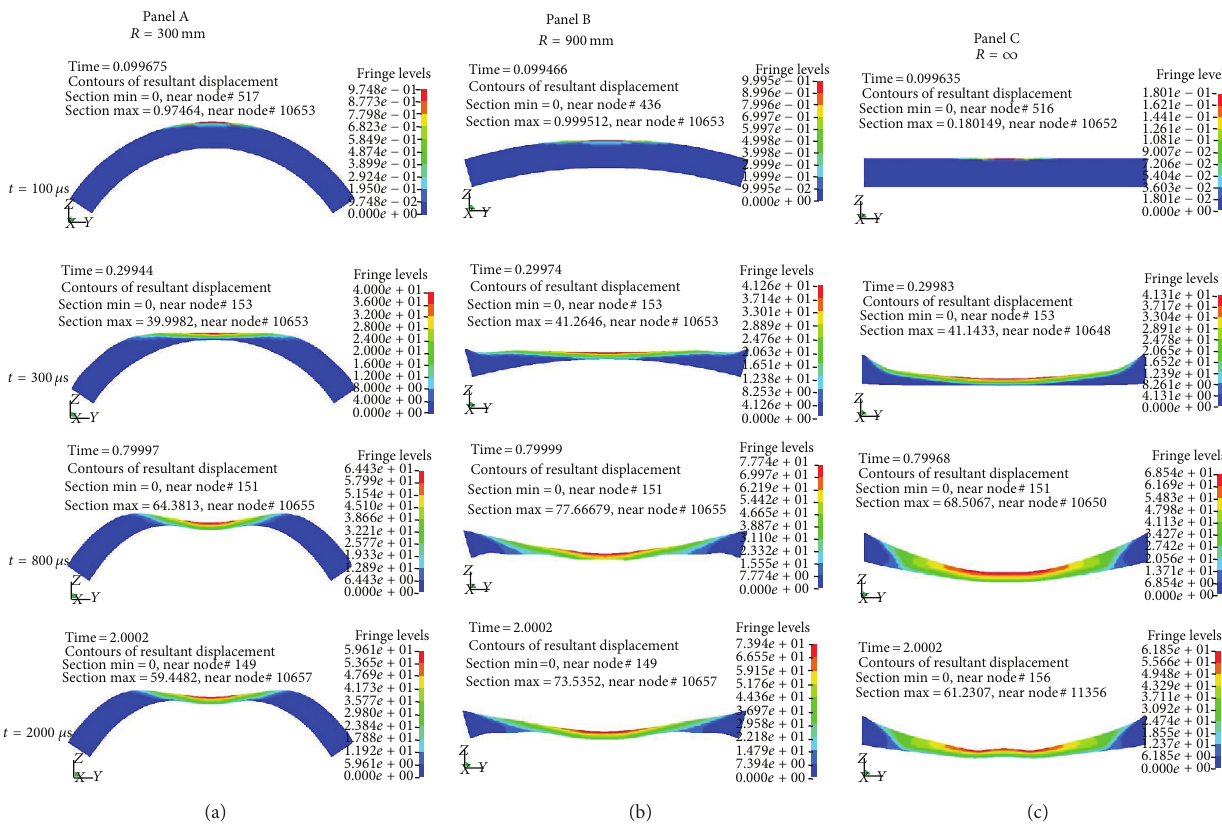
Figure 8: Simulated deformation and resultant displacement contours on the C-planes of curved sandwich panels with different curvatures: (a) 𝑅 = 300 mm, (b) 𝑅 = 900 mm, and (c) 𝑅 = ∞